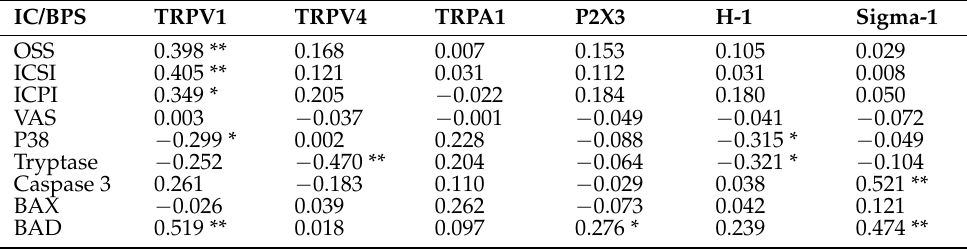
Table 3. The correlation between sensory receptor density and the clinical symptoms, inflammatory and pro-apoptotic protein expressions in the urothelium of patients with interstitial cystitis/bladder pain syndrome.